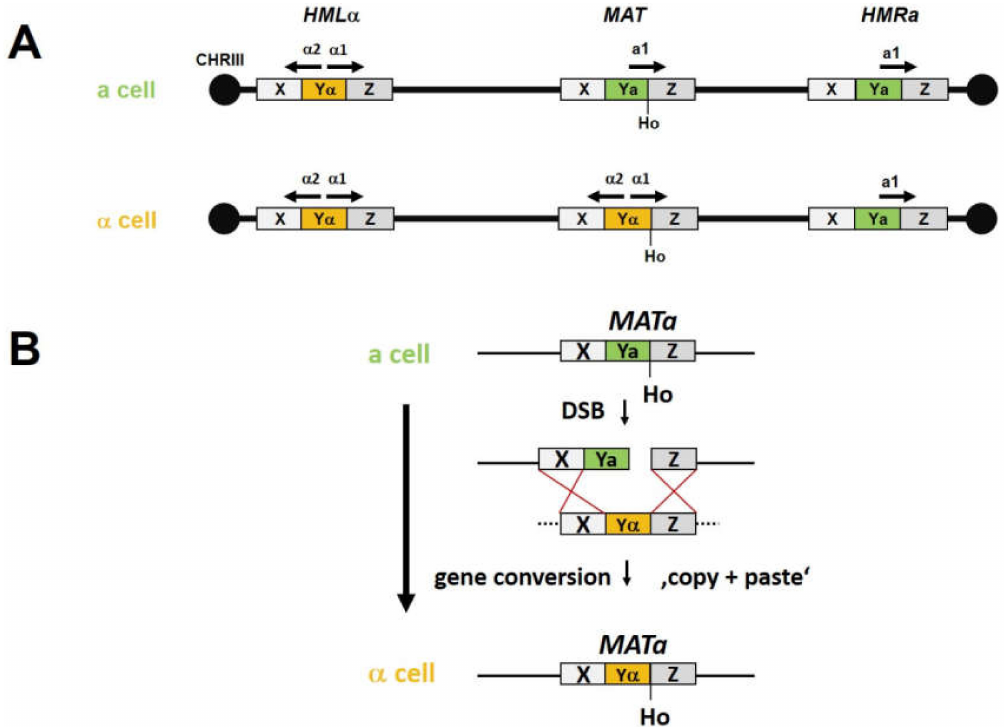
Figure 3. Mating-type switch in Saccharomyces cerevisiae . ( A ) Cell type in S. cerevisiae is determined by the MAT locus. In a cells there is the a allele at the MAT locus, while α cells possess MAT α . The MAT locus resides on CHRIII. At the telomeric ends of this chromosome there are silent cassettes of both mating types, HML α on the left and HMR a on the right. ( B ) Mating-type switching is initiated by the Ho endonuclease which cleaves at a specific site at the border of the Y-Z region generating a double-strand break (DSB). This triggers a gene conversion using, with high fidelity, the opposite silent mating type cassette as template for DSB repair resulting in a mating-type switch